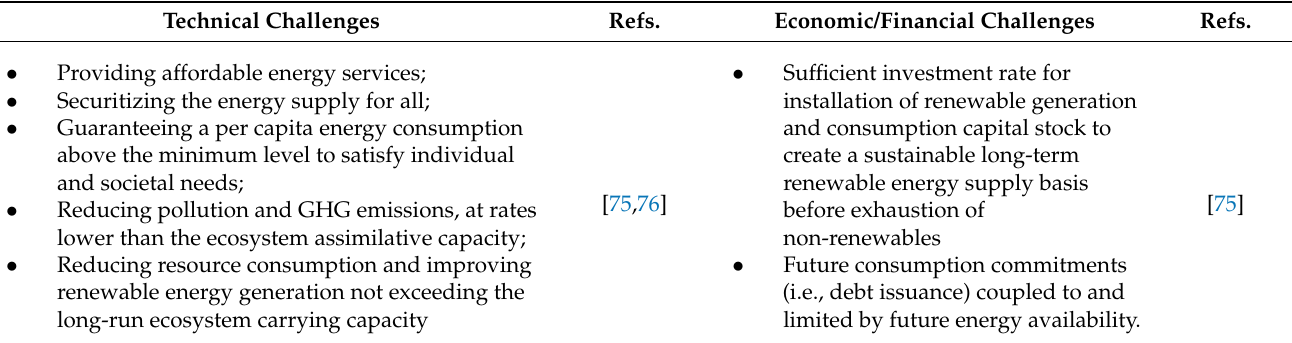
Table 8. Summary of technical and economic/financial challenges for sustainable energy policy solutions. Technical Challenges Refs.